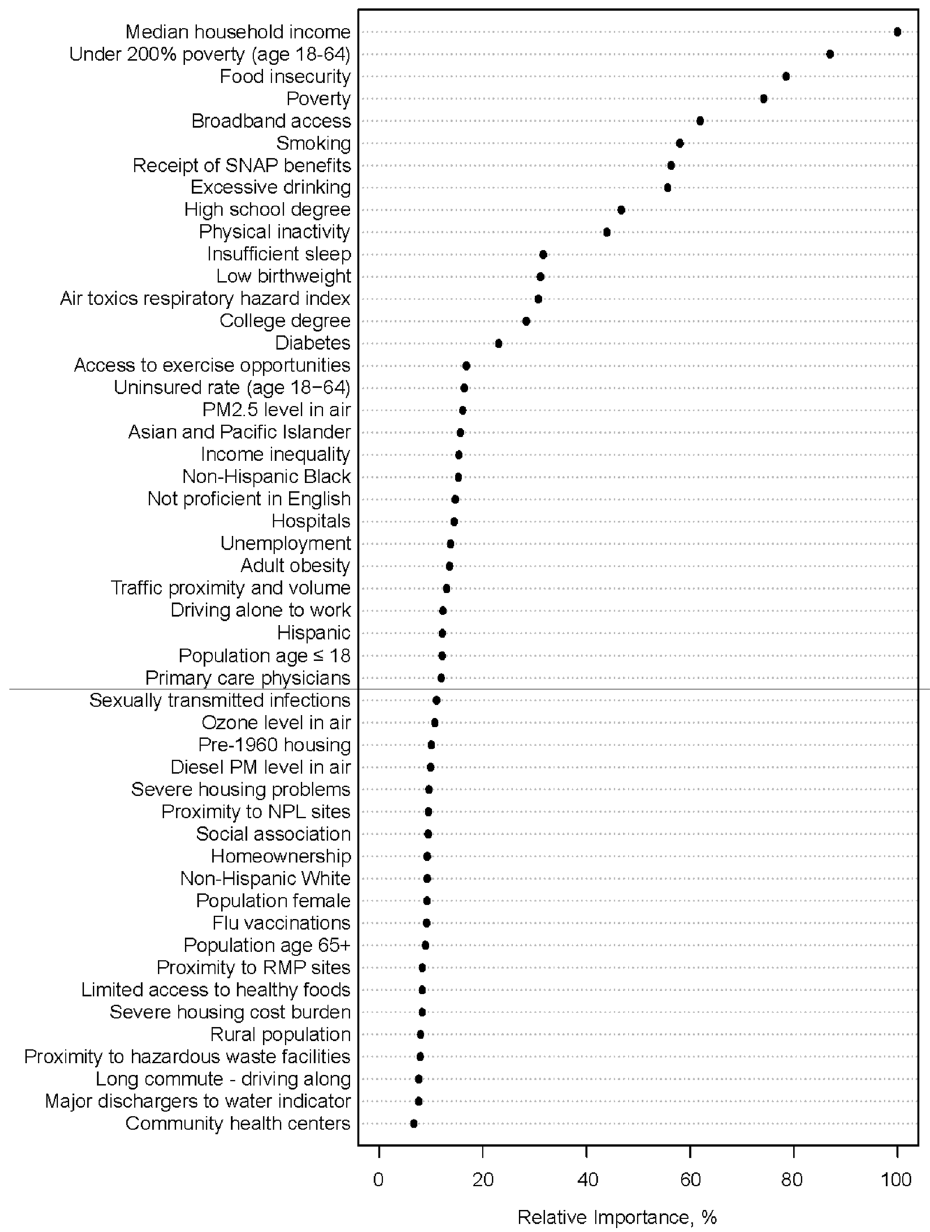
Figure 4. Relative importance plot of risk factors in predicting county-level age-adjusted premature cardiovascular mortality from the random forest analysis. Notes: the most important variable is at the top and scaled to 100%. The importance of the rest of the variables is shown relative to the top variable. Abbreviations: SNAP supplemental nutrition assistance program; PM fine particulate matter; RMP risk management plan; NLP national priorities